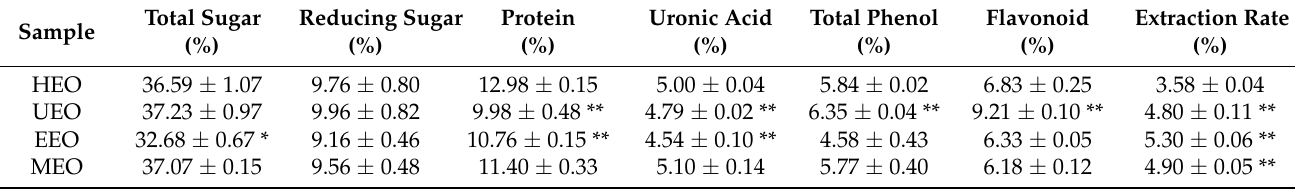
Table 4. Primary physicochemical properties of